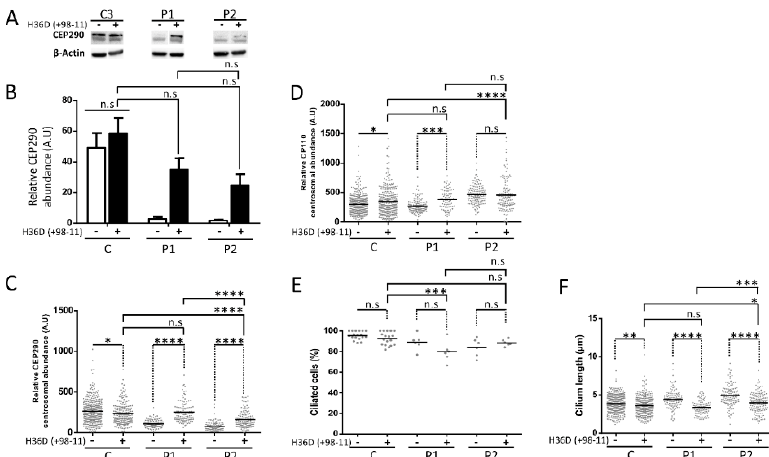
Figure 9. AON-treatment e ff ect at protein level and impact on ciliation. ( A ) CEP290 protein analysis in control and mutant cell lines untreated or treated during 48 h with 75 nM of H36D. ( B ) Quantification of CEP290 protein abundance relative to β -Actin. Bars correspond to the mean value ± SEM from three independent experiments = not significant. A.U. = arbitrary unit. ( C ) Quantification of CEP290 immunofluorescence intensity at the basal body in each cell line. Each dot depicts the labeling intensity of the protein in individual cells recorded automatically from six microscope fields. The solid line indicates the mean. ( D ) Quantification of CP110 immunofluorescence intensity at centrosomes in quiescent fibroblasts. All automatic intensity measures were recorded from six fields. ( E ) Percentage of ciliated cells and ( F ) length of cilia axonemes in control and mutant fibroblasts. A minimum of 90 ciliated cells were considered for each cell lines. C corresponds to C1–C3 pooled values. * p ≤ 0.05, ** p ≤ 0.01, *** p ≤ 0.001, **** p ≤ 0.0001, n.s = not significant, A.U. = arbitrary unit.